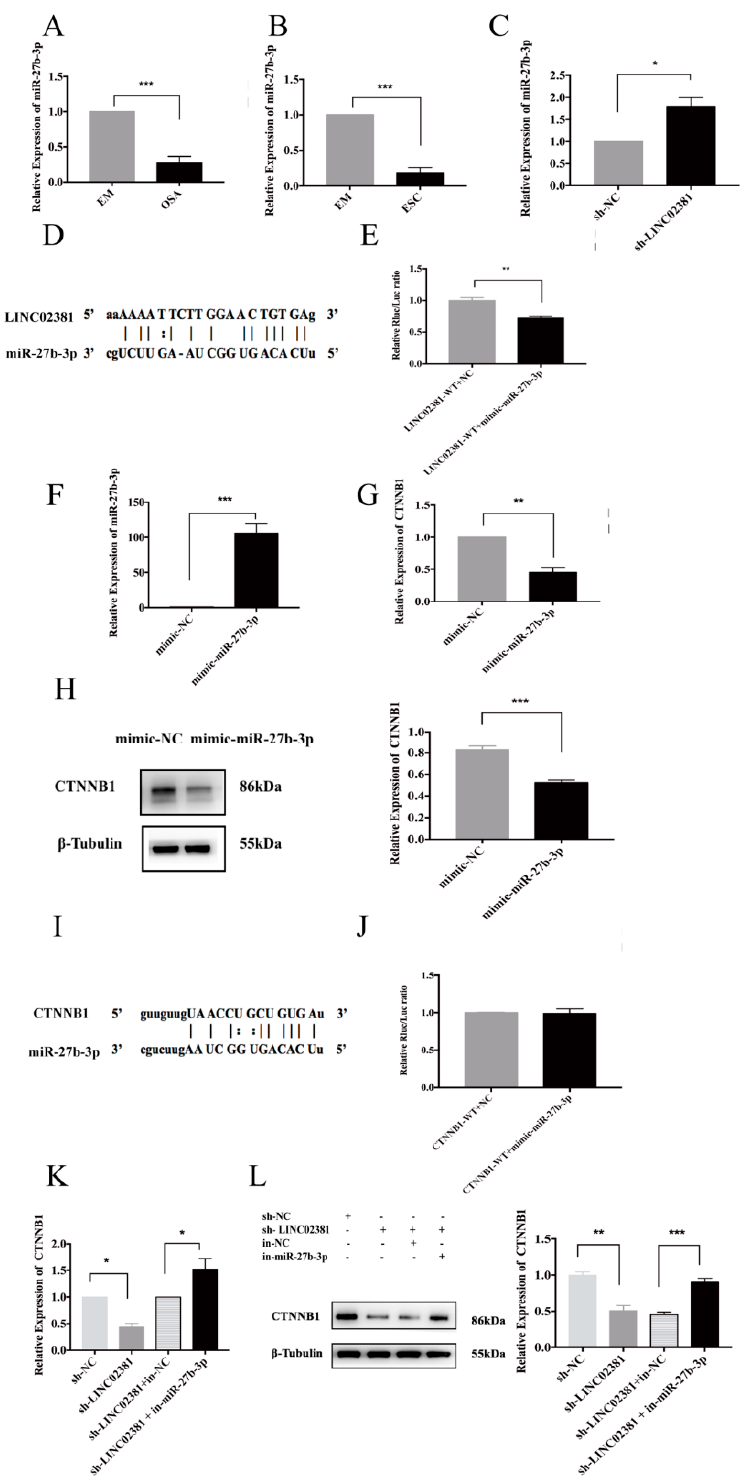
Figure 4. The LINC02381/miR-27b-3p/CTNNB1 regulatory axis. ( A , B ) Paired OSA and EM samples and paired ESCs and EMs were collected for qRT-PCR to quantify the RNA expression of miR-27b-3p ( n = 15, P < 0.001; n = 12, P < 0.001, separately). ( C ) ESCs were harvested for qRT-PCR after